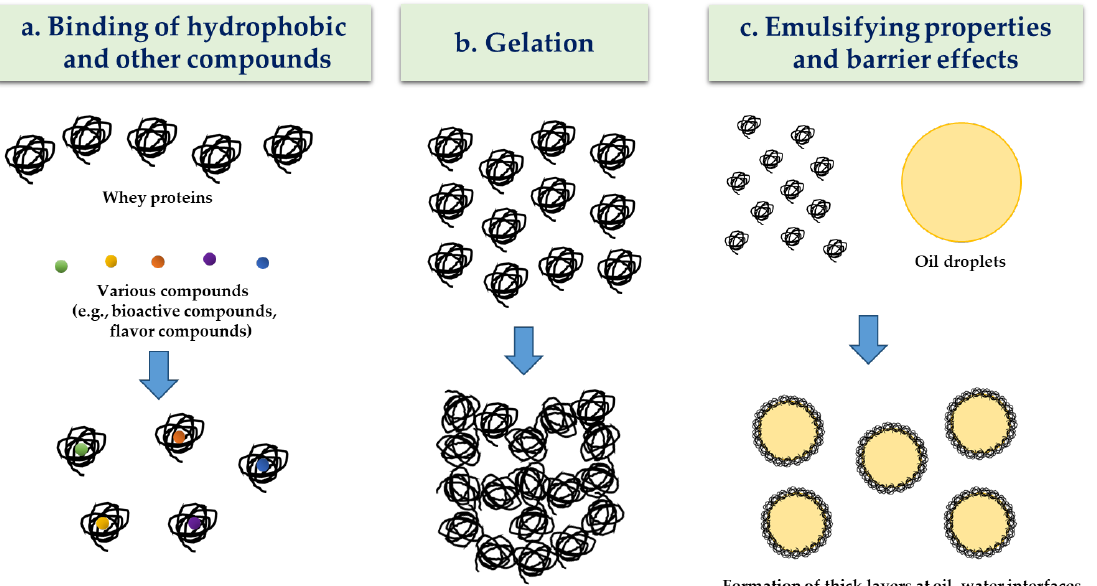
Figure 1. Schematic representation of functional properties of whey proteins as a delivery material. Adapted and modified from Livney et al. [7].